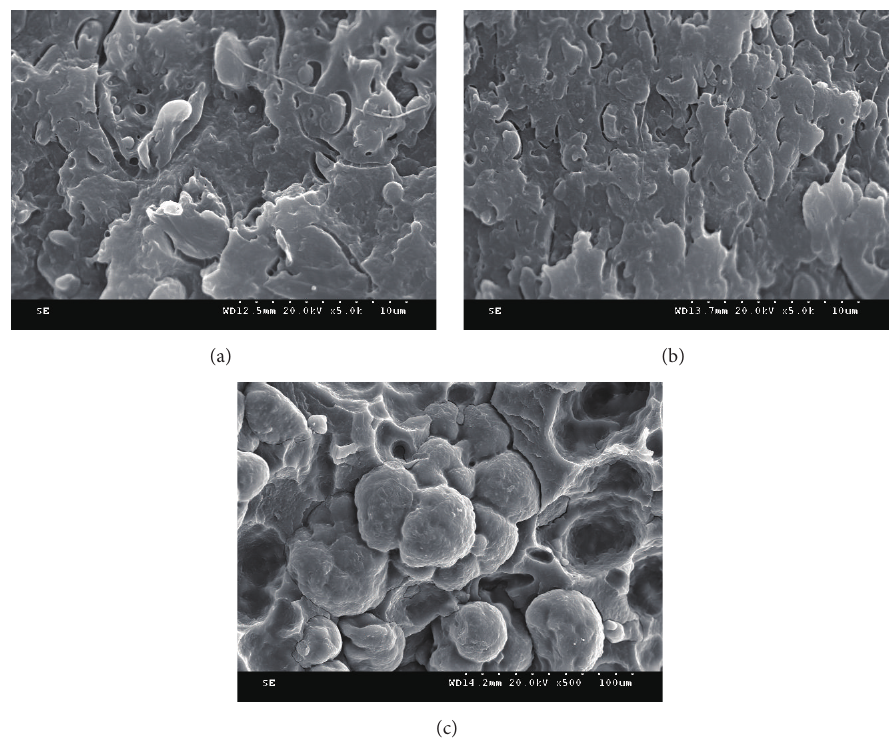
Figure 4: SEM images of UHMWPE/R-PA6/HDPE-g-MAH blending material with different R-PA6 compositions: (a) 40wt% and (b)